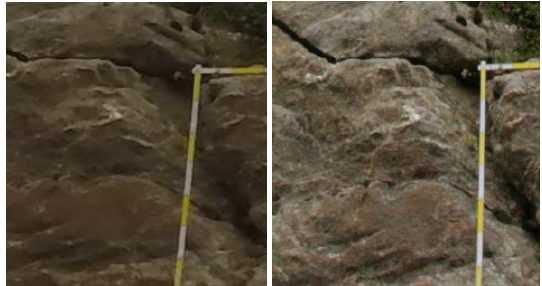
Figure 24. Details of GoPro (left) and Canon 5D (right)